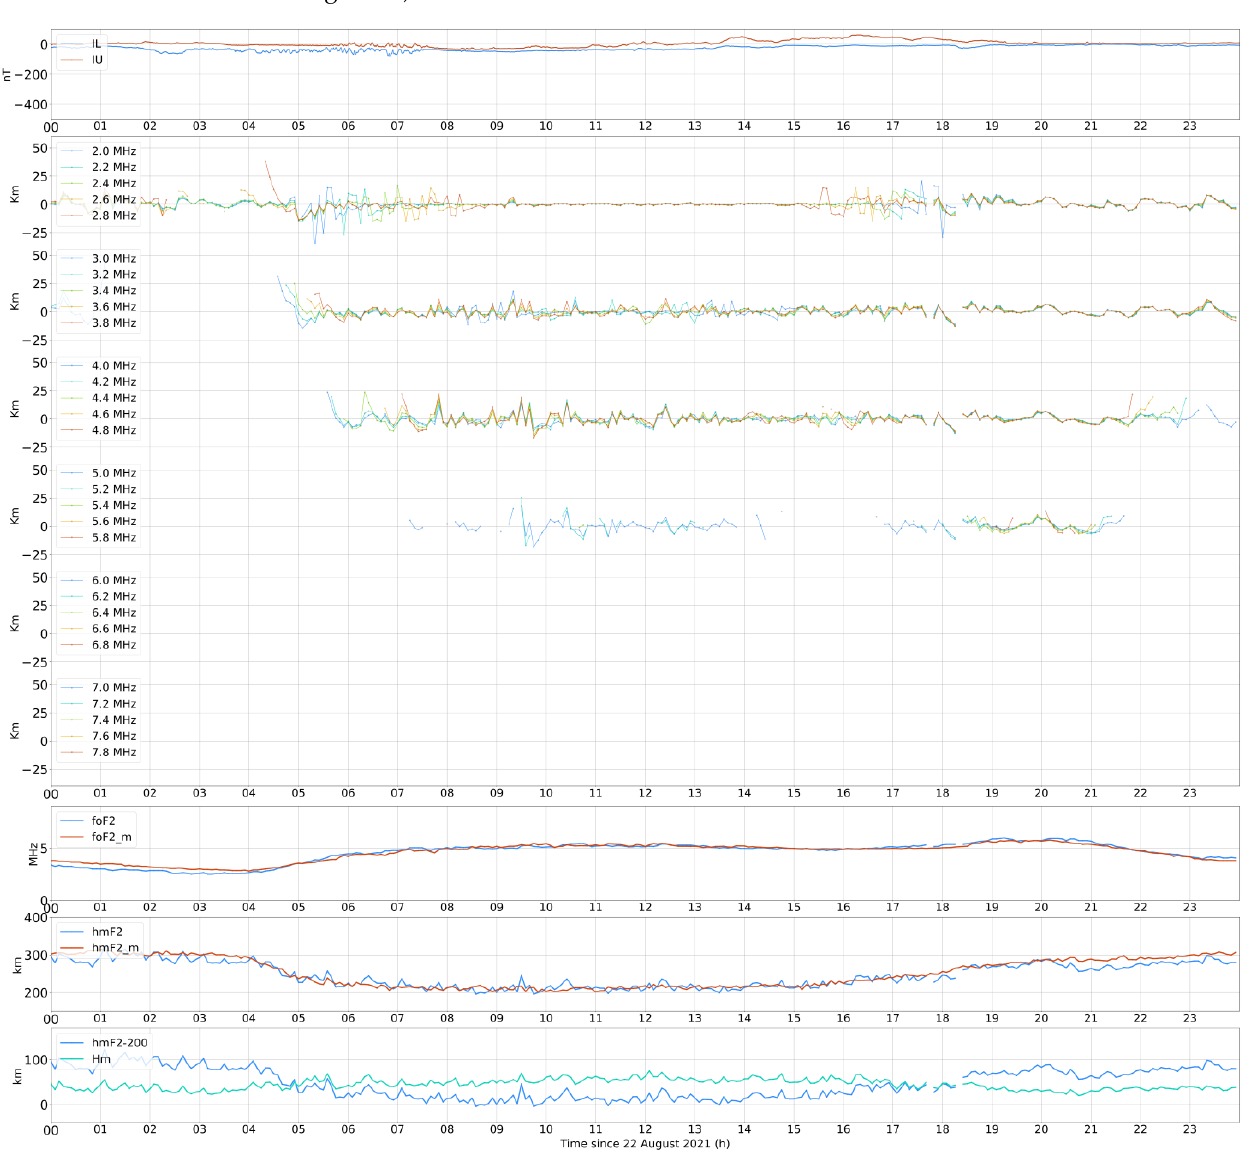
Figure 5. The same as Figure 4 for Dourbes.